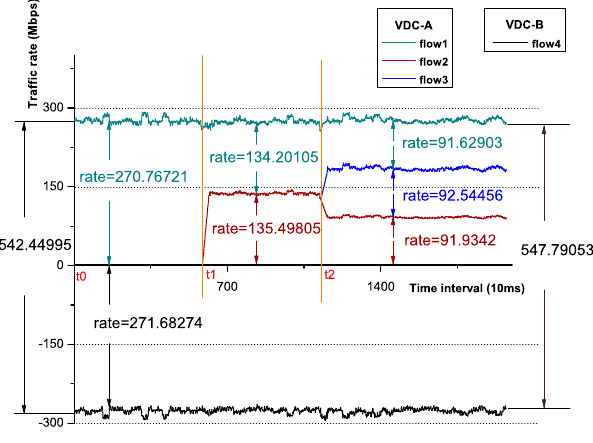
Figure 8. The variation of the flow rates.